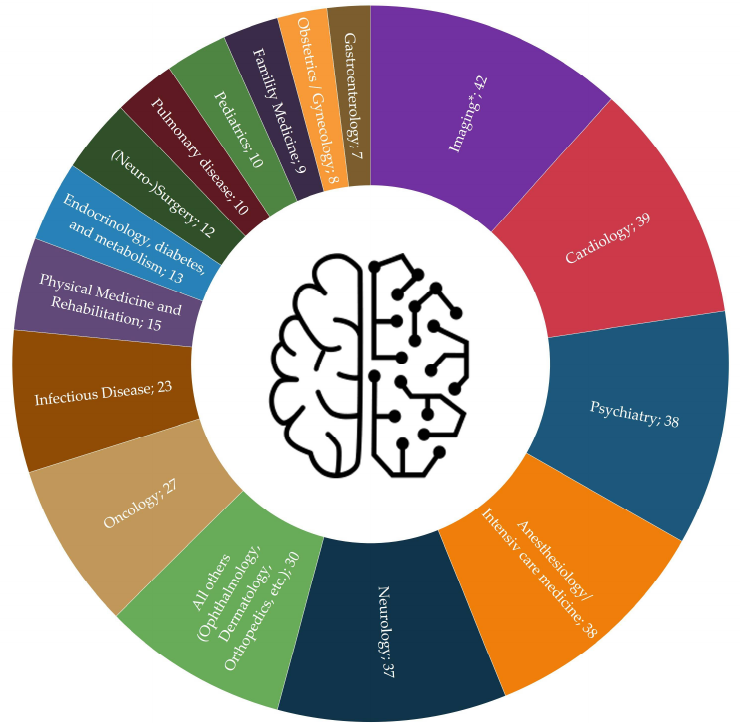
Figure 3. Study entries in the field of ML by study-initiating medical specialty/field ( n = 358). Source: Own figure based on the evaluation of the ClincalTrials.gov dataset [36]. * Dianostic Radiol- ogy/Biomedical Imaging, Radiation Oncology, Nuclear